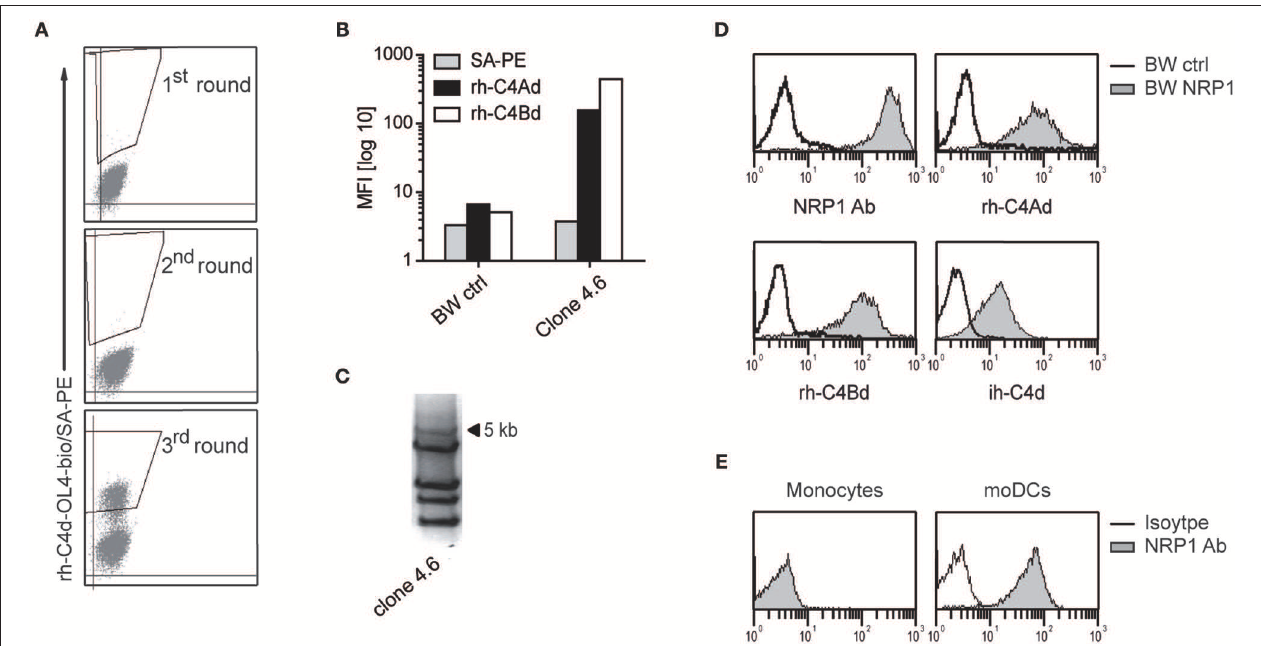
FIGURE 1 | Identification of NRP1 as a receptor for C4d. (A) C4d-reactive cells enriched from a BW cell pool expressing a moDCs-cDNA library by multiple rounds of cell sorting. Sorting gates are shown. (B) A single cell clone derived from the C4d-reactive BW cell pool was probed with rh-C4Ad and rh-C4Bd and analyzed via flow cytometry. (C) PCR-amplification of retroviral inserts of a C4d-binding clone. (D) BW cells expressing a 5kb retroviral insert encoding NRP1 were probed with a NRP1 mAb (monoclonal) or biotinylated rh-C4Ad, rh-C4Bd or ih-C4d (20 µ g/ml each; open histograms: reactivity of NRP1 mAb or C4d to BW control cells; gray histograms: reactivity of NRP1 mAb or C4d to BW NRP1 cells). Biotinylation of rh-C4Ad and rh-C4Bd employed the NHS-biotin procedure, except for ih-C4d, which was specifically biotinylated on the thioester carbonyl moiety employing amine-PEG2-biotin reagent. (E) Monocytes and moDCs analyzed for NRP1 expression